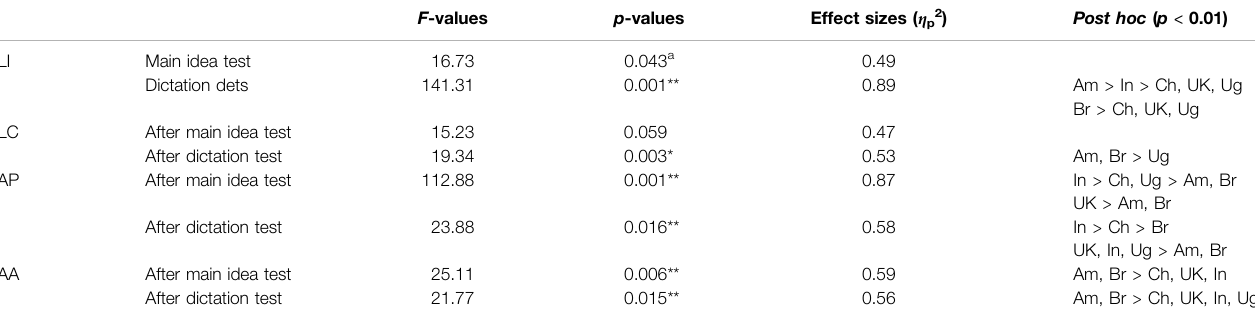
TABLE 2 | Outcomes of robust two-way ANOVAs for group difference in listener intelligibility (LI), listener comprehensibility (LC), accentedness perception (AP), and accentedness acceptance (AA) and pairwise post hoc tests (N (cid:1) 160). F -values p -values Effect sizes ( η p2 ) Post hoc ( p <